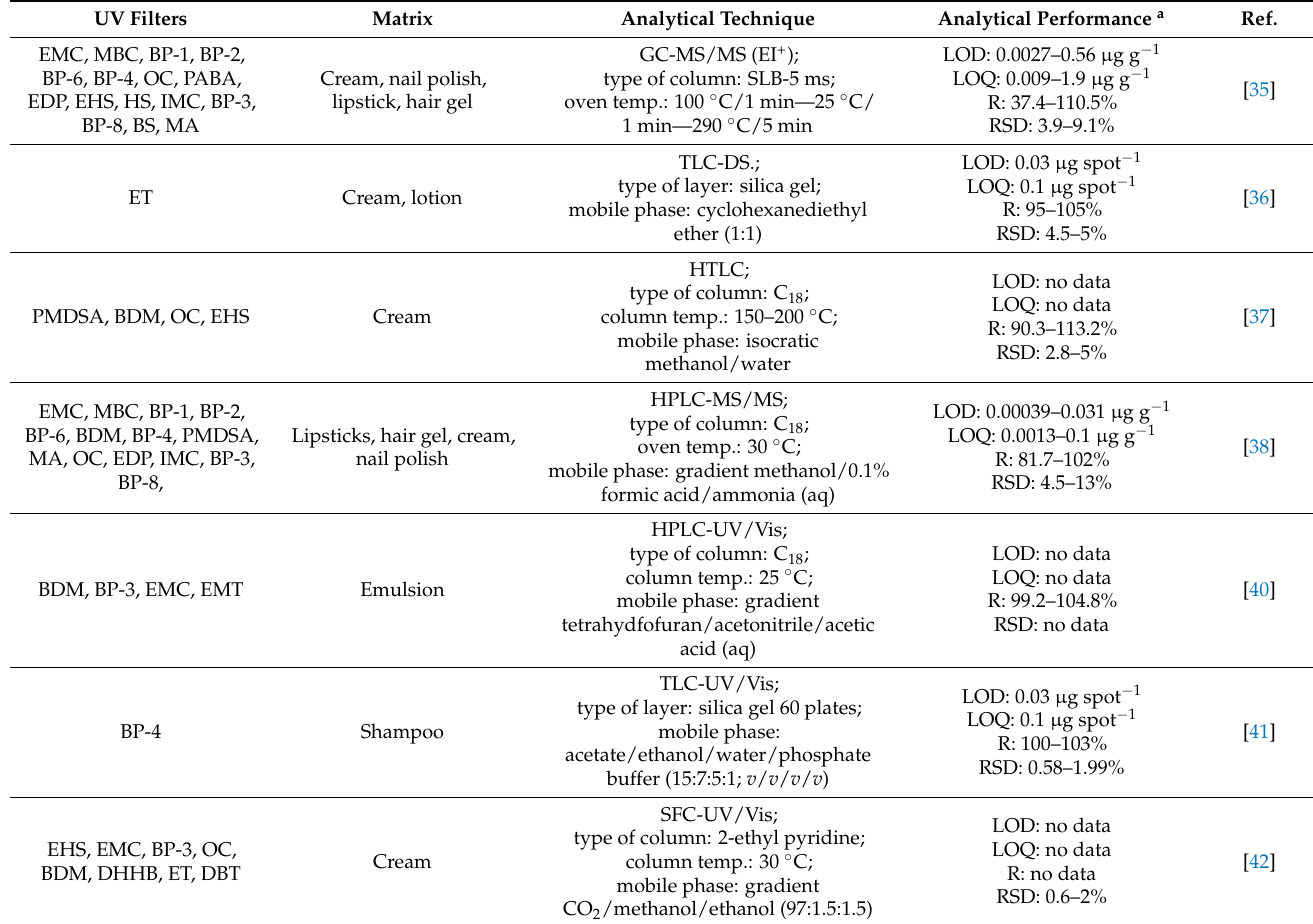
Table 2. Cont. UV Filters Matrix Analytical Technique Analytical Performance